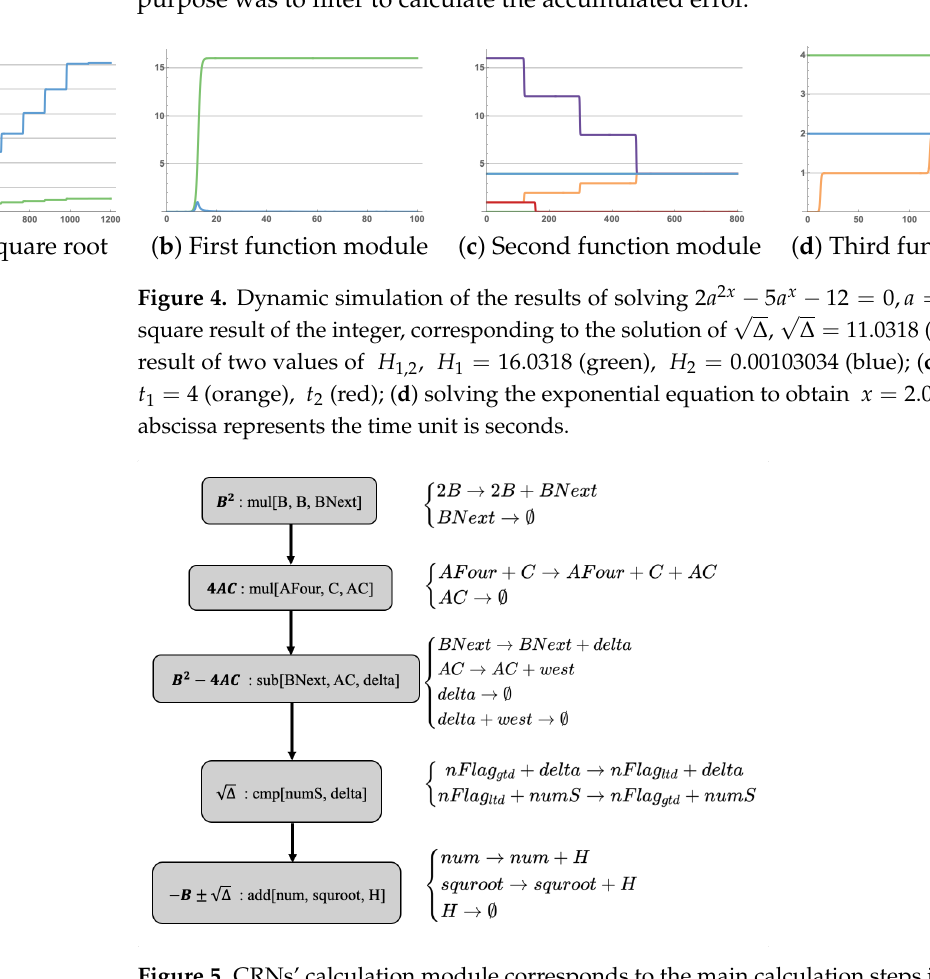
Figure 5. CRNs’ calculation module corresponds to the main calculation steps in the first function